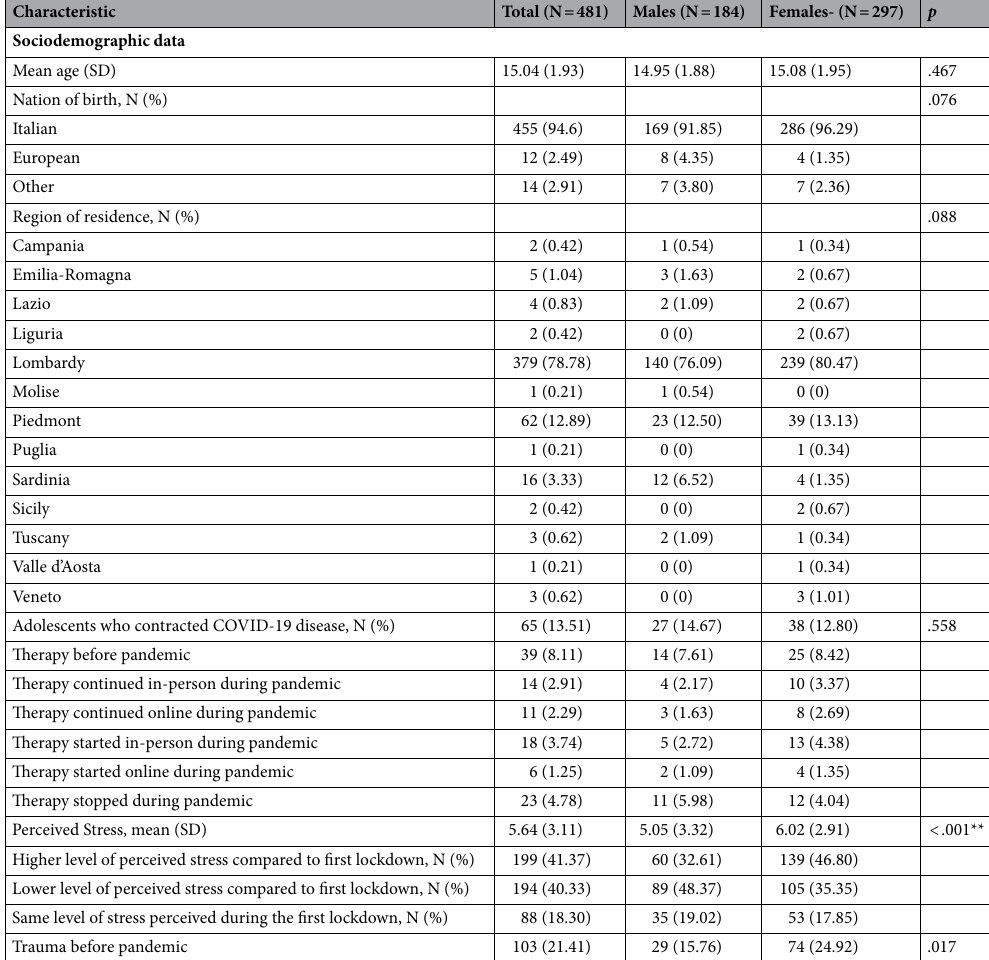
Table 1. Sociodemographic data in the total sample and the two subgroups. Significance: * = < .05; ** < .01.